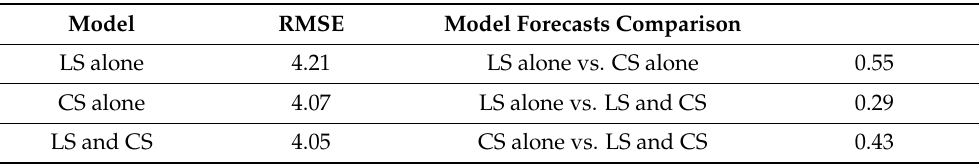
Table 3. Root Mean Square Error (RMSE) and Forecasts Comparison Among Models with LS alone, CS alone, and LS with CS.